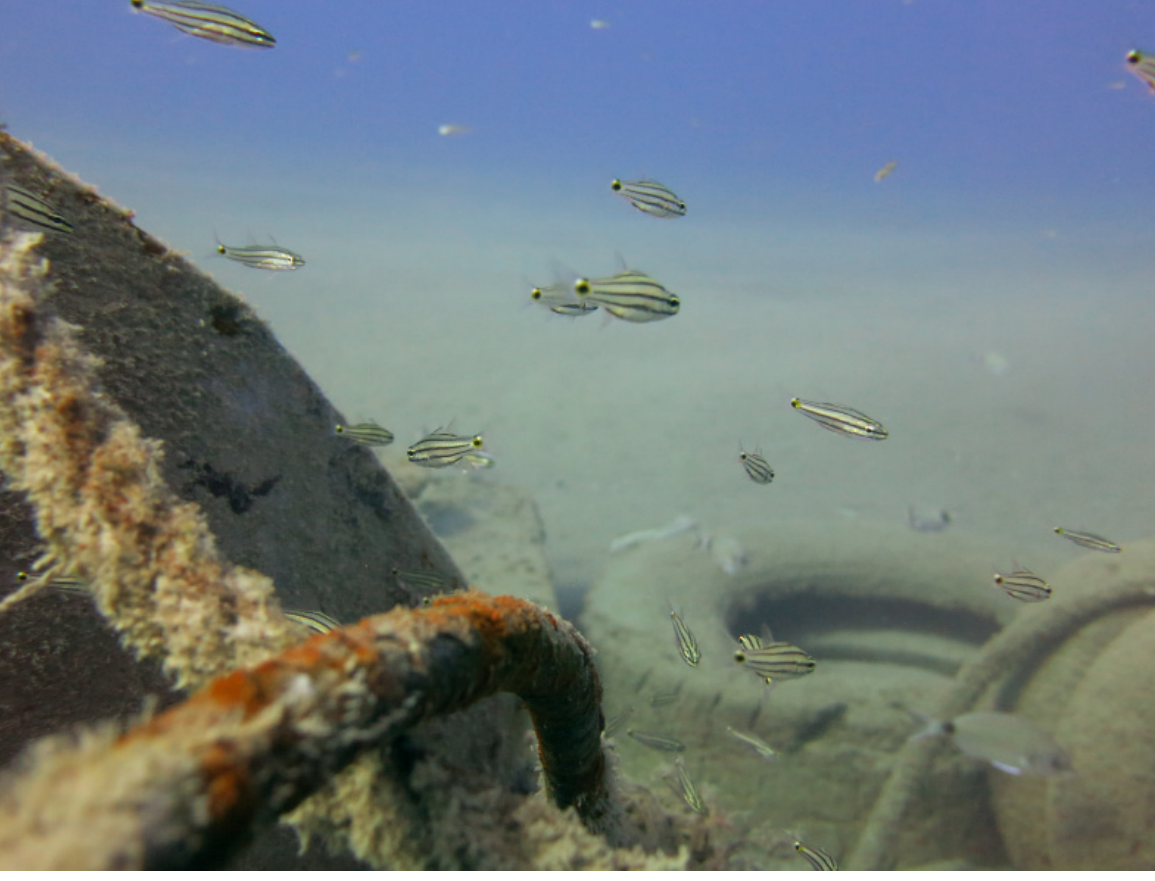
Fig. 2. Underwater photos of Indian Ocean twospot cardinalfi sh, Cheilodipterus novemstriatus , at Cevlik coast, Iskenderun